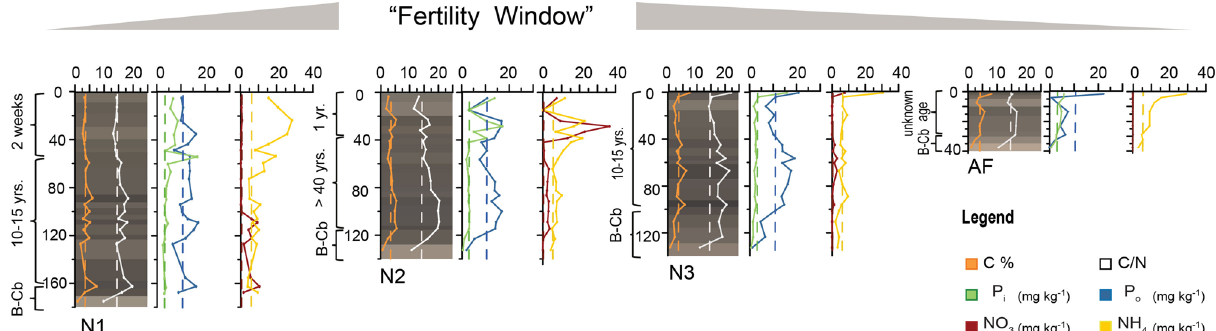
Figure 4. Fertility over time. The three different phases in the cycle of cultivation represented by fields N1 (two weeks after addition of fresh biomass to rehabilitate a field that had been left fallow for at least 10 years), N2 (one year after rehabilitation, field age > 40 years), and N3 (fallow, since about 10 years). Some fields are not only left fallow, but abandoned (AF, abandoned at least 20 years ago). Peak of chemical fertility in the layers where crop roots are concentrated is reached some months to one year after rehabilitation for cultivation (“Fertility Window”). Fertility then declines, returning to values typical of nearby uncultivated soils during the fallow period and falling even lower with abandonment. Plots show downprofile colour (visualized by conversion of spectrophotometrically measured colour space values into the RGB colour space 39 and chemical analysis of the main profiles (X) of fields N1, N2, and N3. Dashed lines in the background are the mean values for each chemical parameter of the topsoil (Ah) samples taken at 10 cm depth from areas near each field in the RFSA. (Graphs were plotted with Grapher and arranged using Adobe